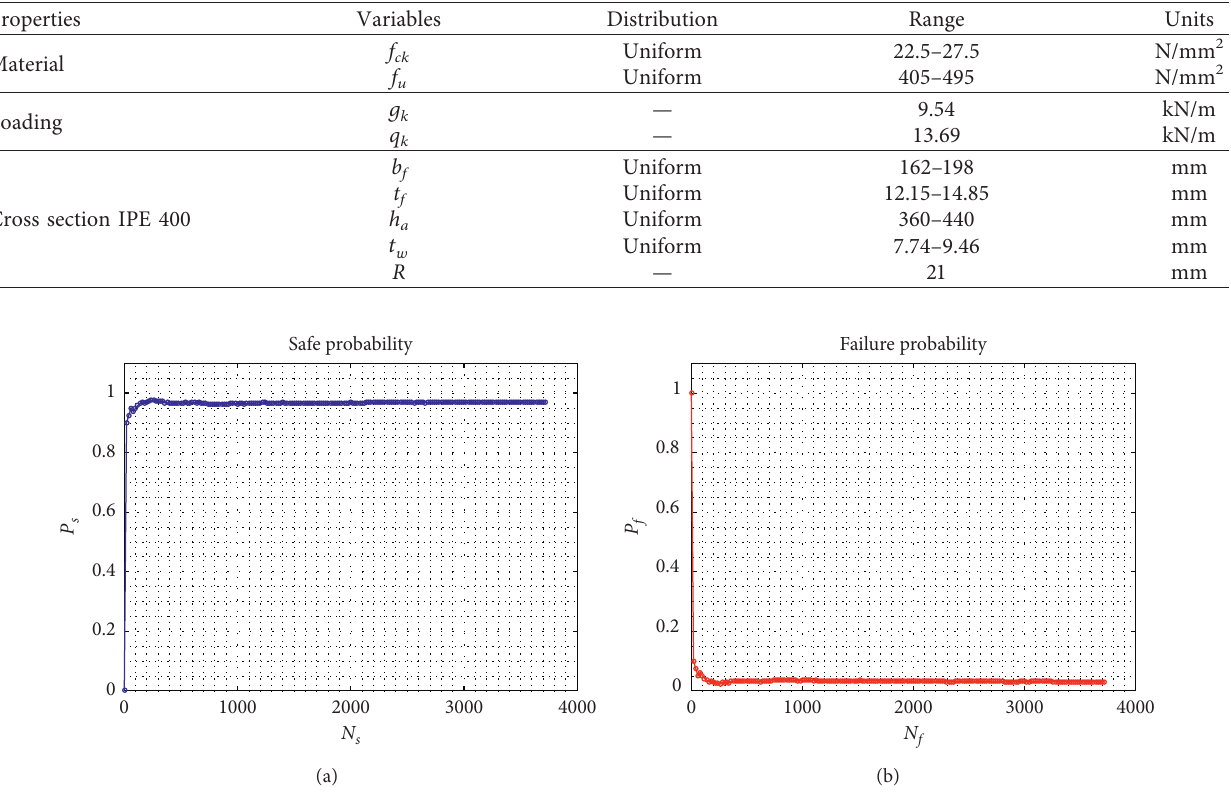
Table 6: Statistical properties of random variables for Sobol’s indices sensitivity analysis.